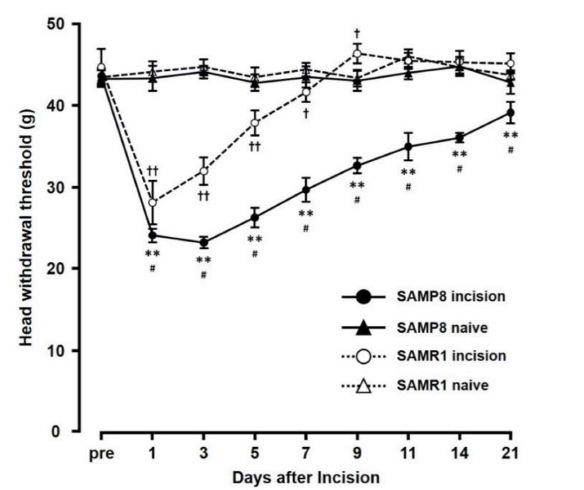
Figure 1. Changes in mechanical head-withdrawal threshold (MHWT) at the incision site over 21